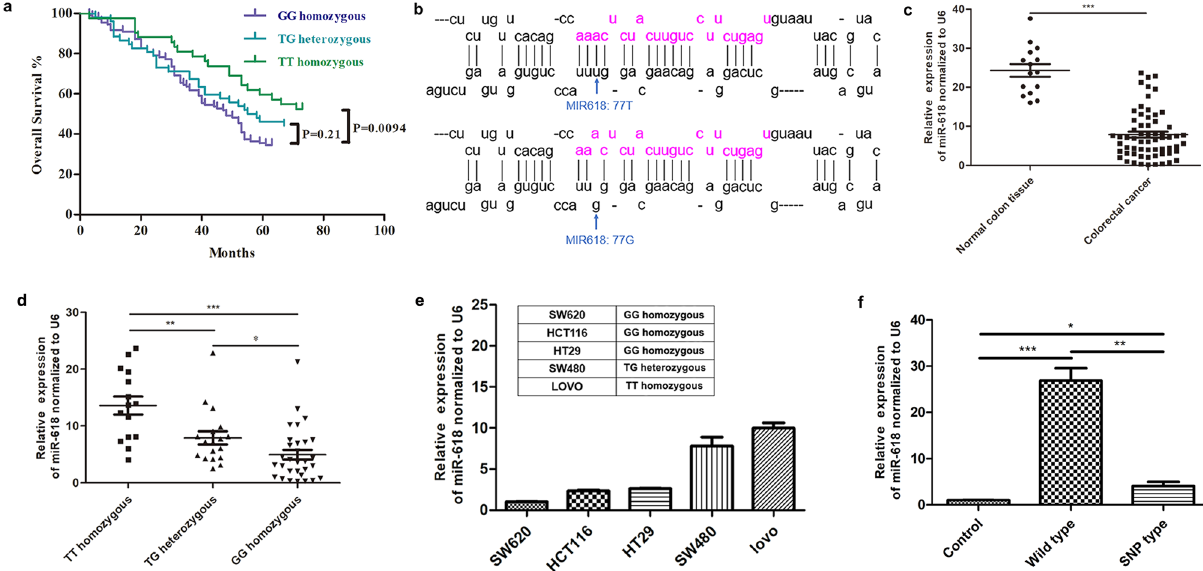
Figure 1. Polymorphism rs2682818 is associated with down-regulation of miR-618 and the CRC risk. ( a ) Kaplan–Meier survival curve constructed for totally 205 colorectal cancer patients, who were divided into three groups according to the rs2682818 allele: homozygous (TT) genotype (n = 111) , homozygous (TG) genotype (n = 52) and homozygous (GG) genotype (n = 42). The survival data of each group were used to construct the K-M survival curve with CI = 95%, which can be further used as the historical reference survival curve. ( b ) In silico prediction of the secondary structure of different pre-miR-618 molecules. ( c ) q-PCR analysis of miR- 618 in normal colon tissues and colorectal cancer tissues, in which U6 served as an internal control. Statistical analysis is done for groups with line, and the adjusted p value is represented above the line. *** P < 0.001 (t-test). ( d ) q-PCR analysis of miR-618 in colorectal cancer tissues which were divided into three groups, and U6 served as an internal control. Statistical analyses are done for groups with lines, and the adjusted p value are represented above the lines. * P < 0.05, ** P < 0.01, *** P < 0.001 (t-test). ( e ) q-PCR analysis of miR-618 in different colorectal cancer cell lines, and U6 served as an internal control. ( f ) q-PCR analysis of miR-618 in 293T cells